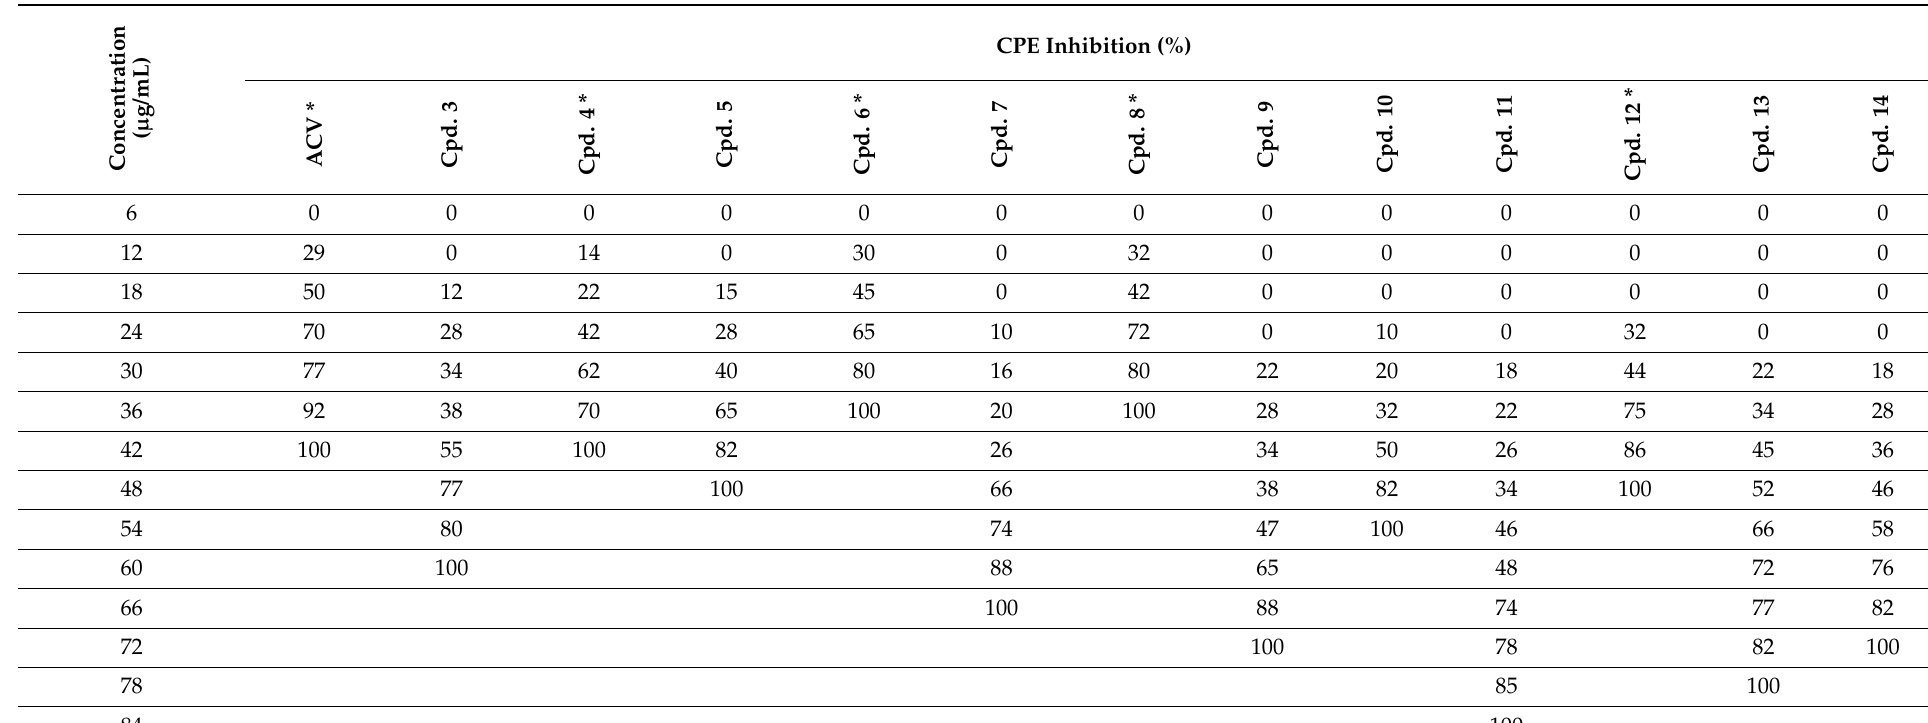
Table 1. Inhibition of HSV-1-related CPE using different concentrations of tested compounds and a standard drug